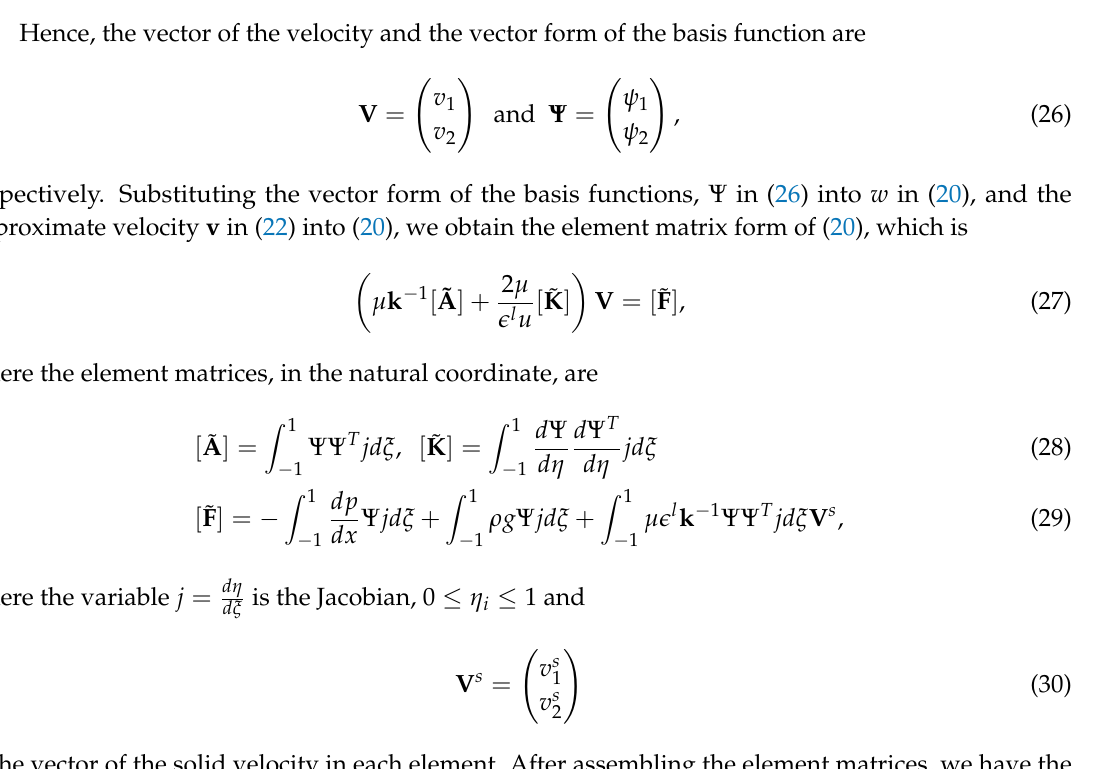
Figure 4. Physical ( above ) and natural ( below )